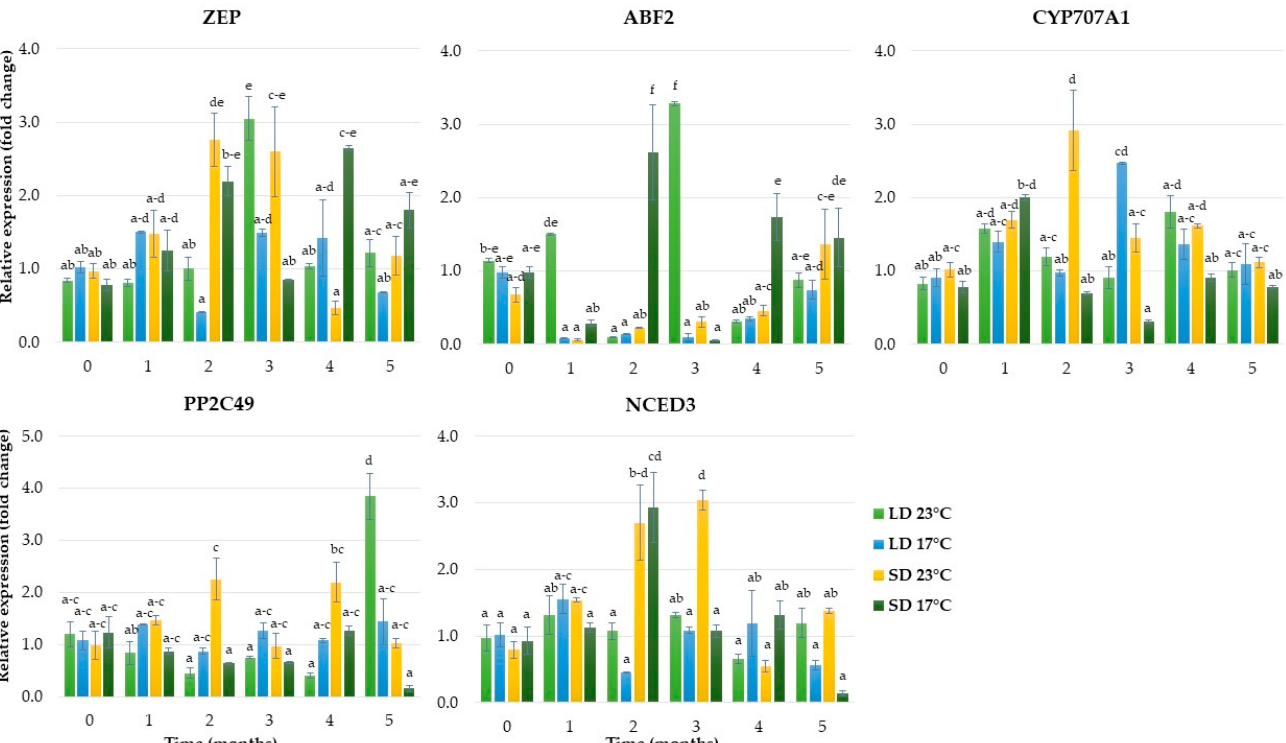
Figure 6. The relative expression of the genes involved in abscisic acid metabolism in rhubarb buds during ex vitro growth under different temperatures (17 °C and 23 °C) and photoperiods (16 h and 10 h). According to Duncan’s test ( p = 0.05), means marked with the same letter do not differ significantly ( p = 0.05). Error bars represent standard deviation.